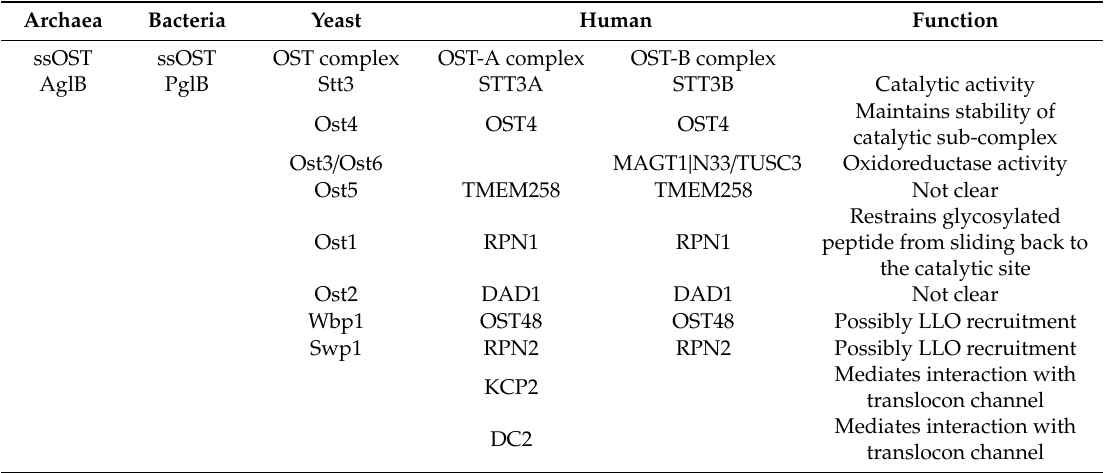
Table 1. OST subunits and their functions across three domains of